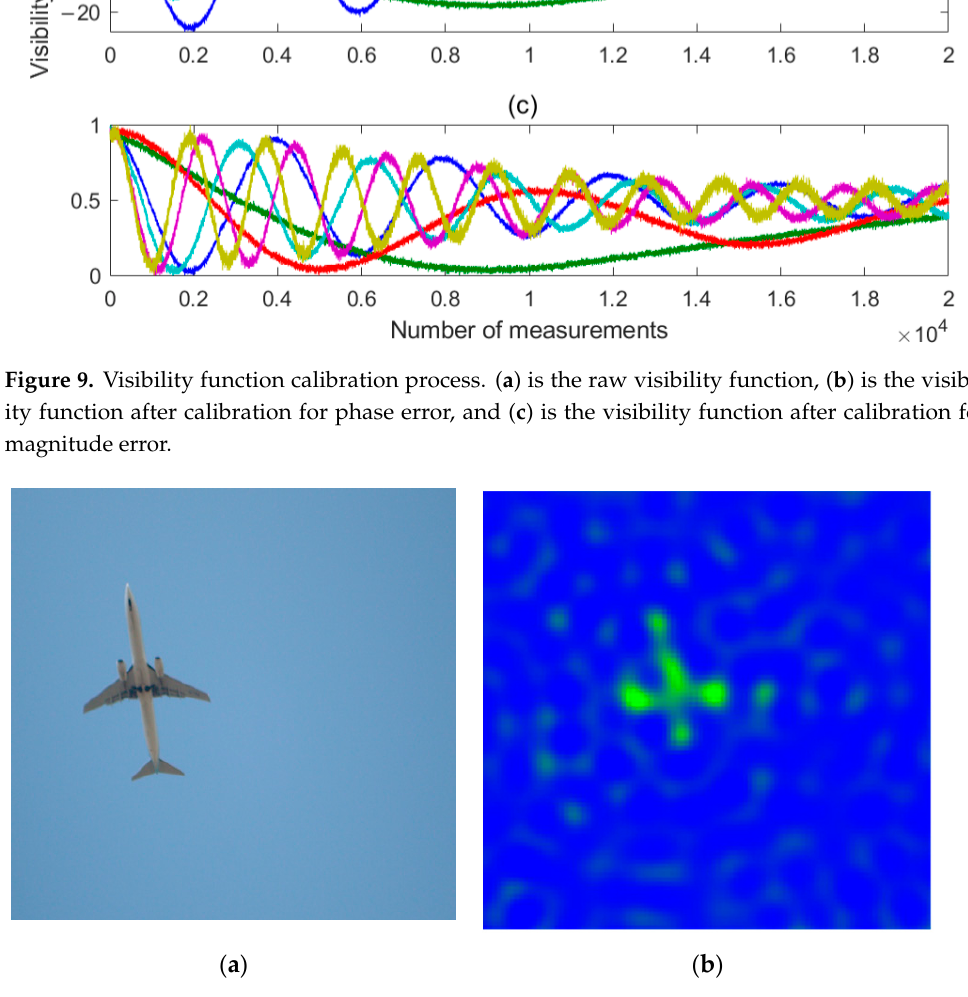
Figure 10. Optical imaging and GSAMR imaging of aircraft. ( a ) Is the image of the aircraft taken using the optical device, ( b ) is the image result of the simultaneous GSAMR system.